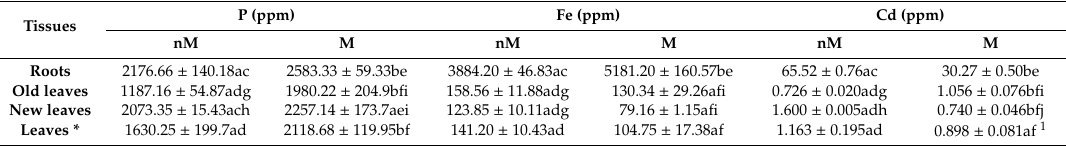
Table 3. Phosphorus, Fe, and Cd concentrations in tissues of non-mycorrhizal (nM) and mycorrhizal (M) soybean plants after 40 days of Cd